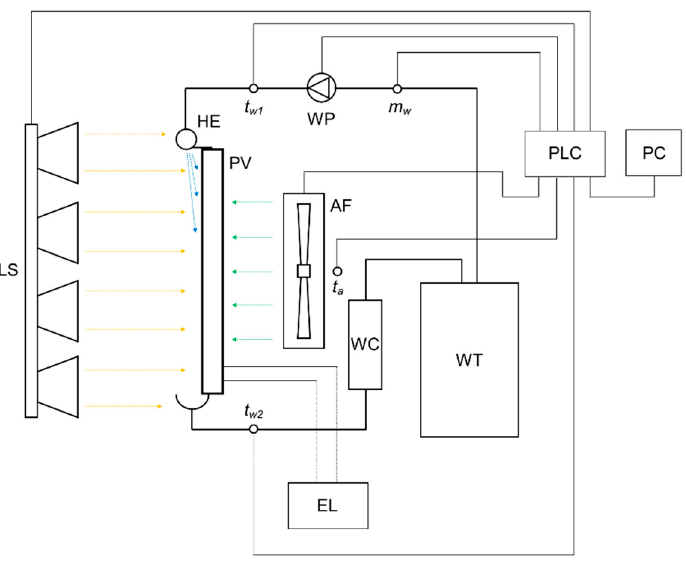
Figure 3. General scheme of the experimental rig (PV: PV panel, LS: light source, AF: air fan, WT: water tank, HE: header, WP: water pump, WC: water cooler, EL: electronic load, PLC: programmable logic controller, PC: computer, t w1 , t w2 , t air : temperature sensors, m w : water flowmeter).